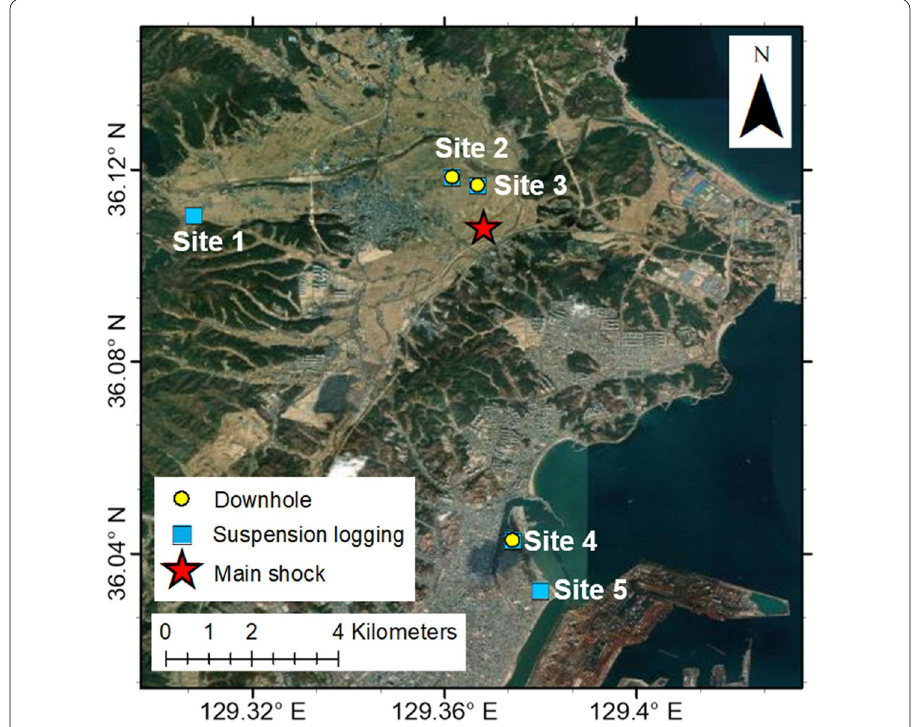
Fig. 1 Map of study area in Pohang City, where the locations of field tests and the epicenter of Pohang earthquake are